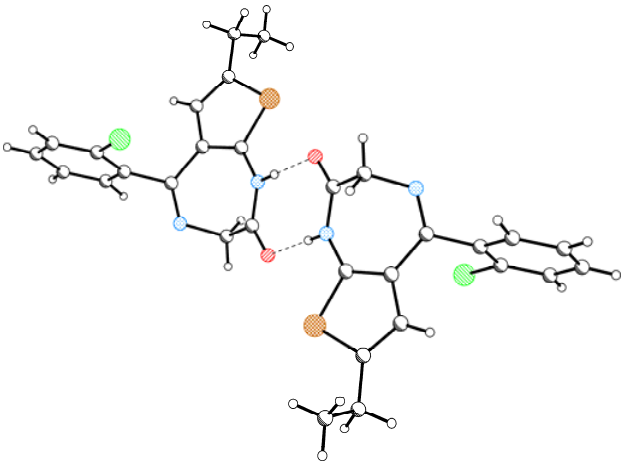
Figure 3. Hydrogen-Bonded R 2 as dashed lines.